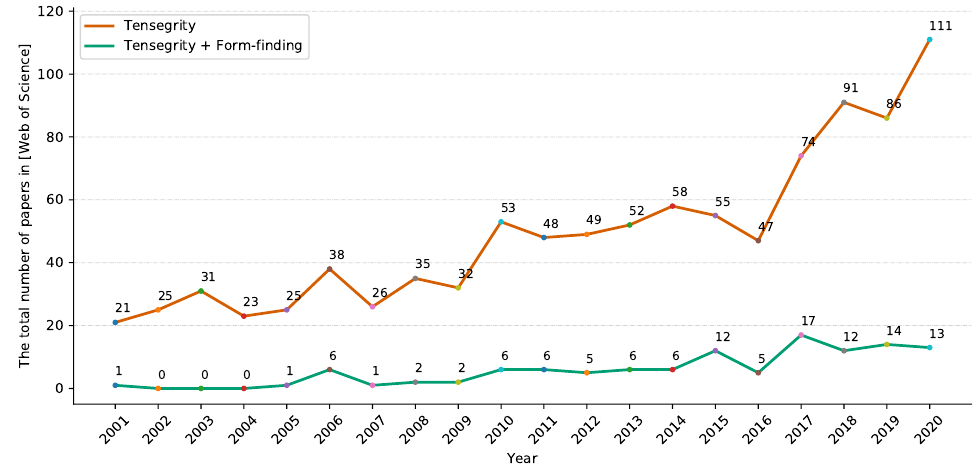
Figure 1. The total number of articles and papers on the Web of Science homepage. Results using subjects, ‘Tensegrity’ and ‘Tensegrity +